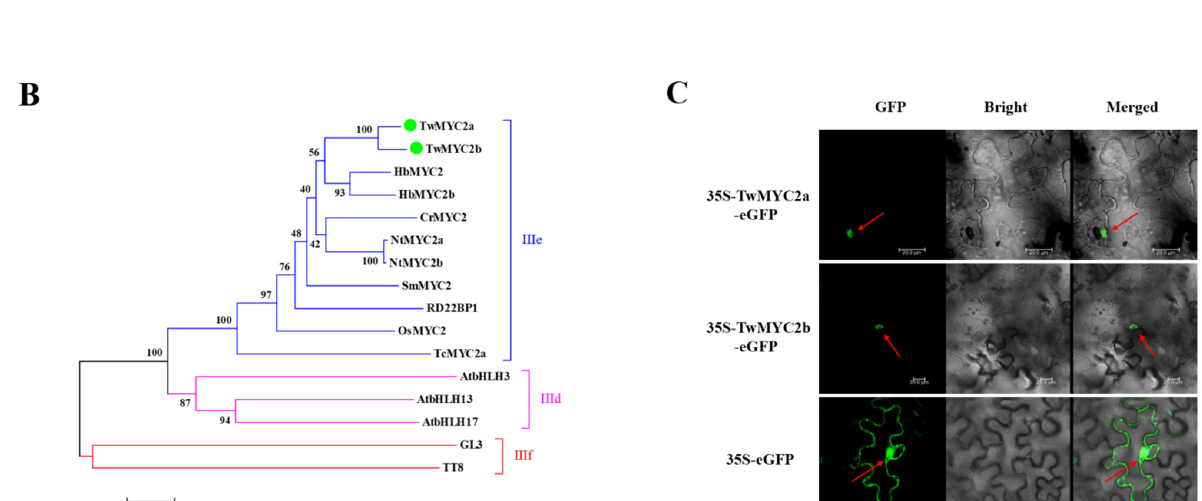
Figure 1. Multiple sequence alignment, phylogenetic analysis, and subcellular localization analyses of TwMYC2a/b. ( A ) Multiple sequence alignment of the TwMYC2a/b protein sequences with their homologous MYC2 proteins from different plant species: Ricinus communis RcMYC2 (XP_002519814.1), Euphorbia lathyris ElMYC2 (AVA18027.1), Ziziphus jujuba ZjMYC2 (XP_015896923.1), Morus notabilis MnMYC2 (XP_010104300.1), Populus tomentosa PtMYC2 (AZQ19203.1), and Prunus persica PpMYC2 (XP_020419289.1). The bHLH-MYC-N domain, bHLH-leucine zipper domain, and phosphorylation site were marked with an overline. JAZ interaction domain was marked with an underline. The nuclear localization signal (NLS) was represented by a solid box. ( B ) Phylogenetic analysis of TwMYC2a/b and other clades IIId/IIIe/IIIf bHLHs. Numbers at nodes represent bootstrap values (based on 1000 resamplings). The scale bar indicates the evolutionary distance. TwMYC2a/b are represented by large green dots. Accession NO. in GenBank: AtMYC2 (also called RD22BP1,